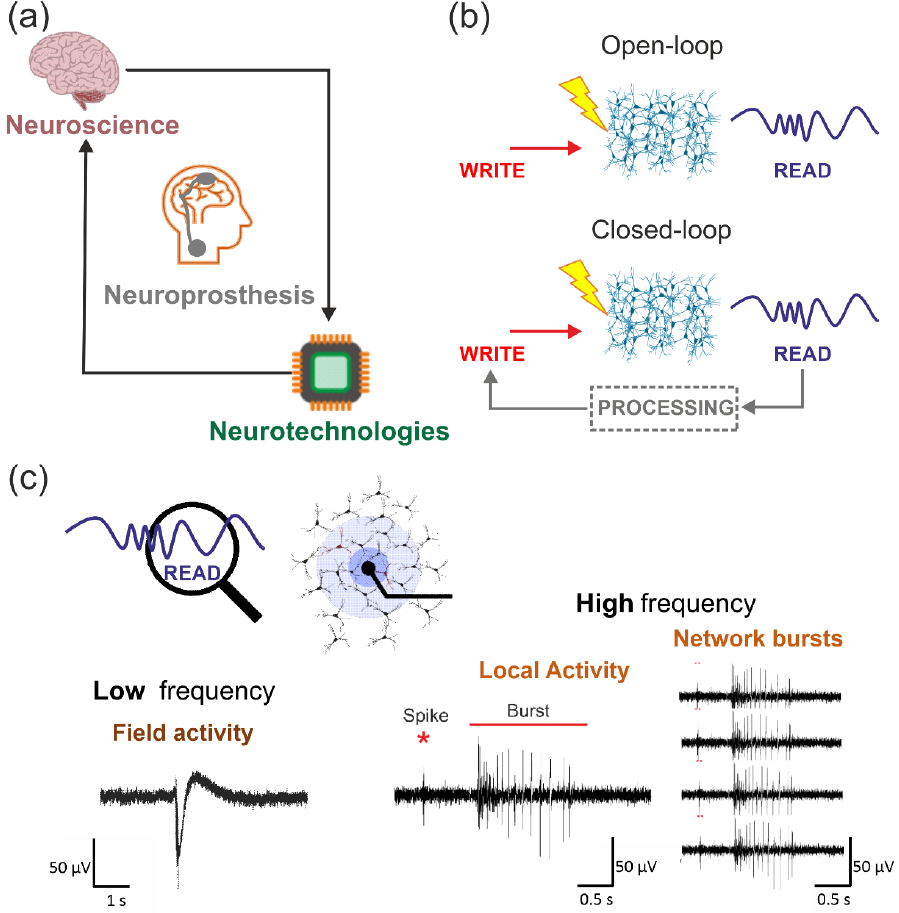
Figure 1. The main elements of a neuroprosthesis. ( a ). Neuroprostheses are the results of the dual interaction between neuroscience and neurotechnologies. ( b ). Open- and closed-loop architectures. In the open-loop modality (top), the delivered stimuli are not correlated to the network activity. On the contrary, closed-loop configurations (bottom) are based on feedback: the signals coming from the network are processed and specific features are extracted, thus producing triggering events which are responsible for delivering stimulation pulses according to the read network state. ( c ). Various options on the reading side are available for closed-loop. In the low frequency bands (up to 300 Hz), local field potentials can be detected, which carry information from a larger volume of the brain tissue and thus are more informative of the network activity. The high frequency components of the signal (>300 Hz) are characterized by fast extracellular spikes (indicated with a red asterisk—*), which represent the local activity in the neighborhood of the electrodes. Groups of spikes represent a burst (indicated by a horizontal red bar), while the presence of several bursts on the different recording electrodes generates the ‘network